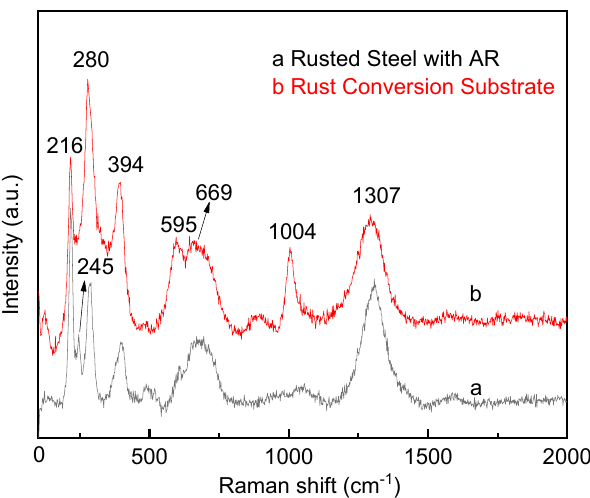
Figure 8. Raman spectra of ( a ) Rusted Steel with AR and ( b ) Rust Conversion Substrate.